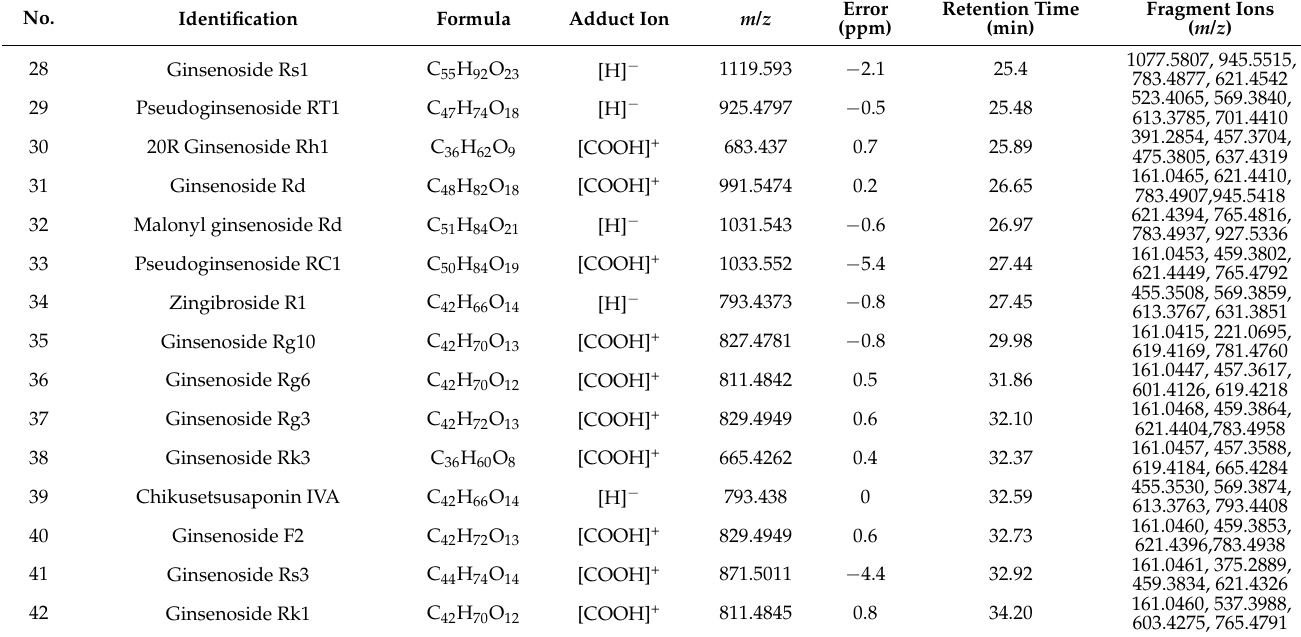
* indicates ingredients belong to GG; ** indicates ingredients belong to